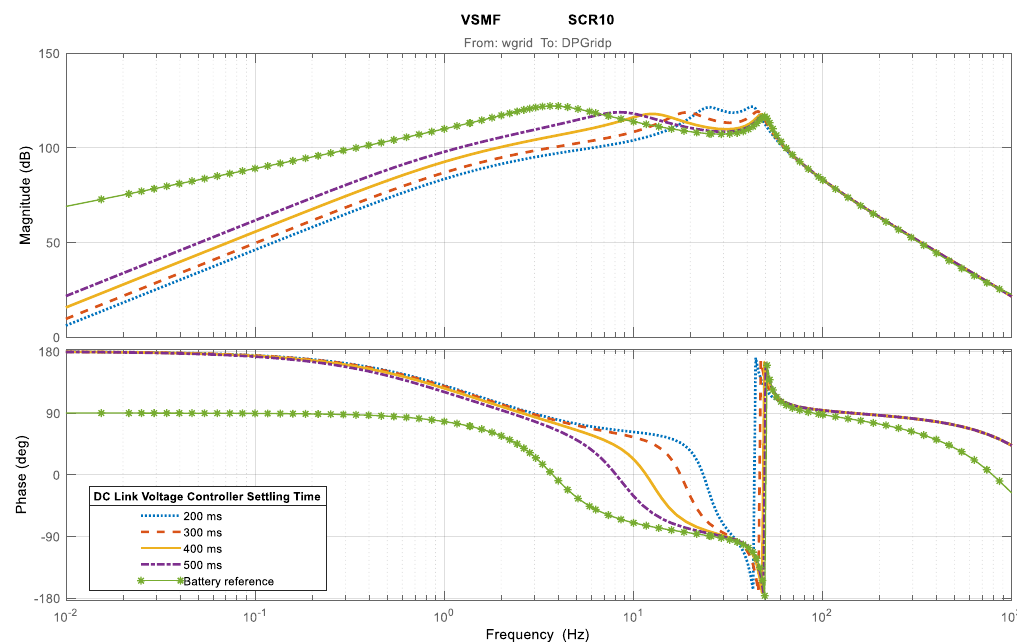
Figure 19. Bode plots showing the effect of the DC link controller bandwidth on the VSM frequency response.